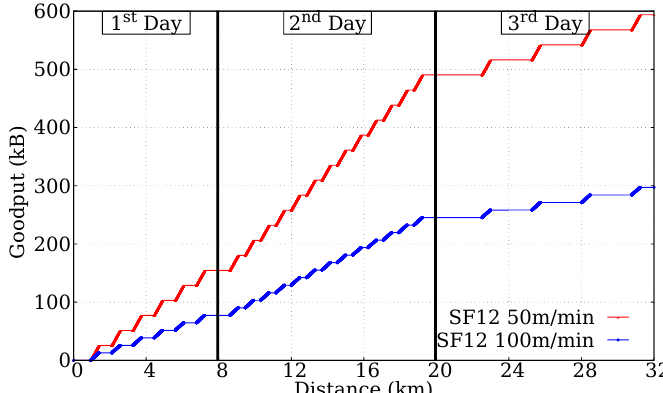
Figure 20. Accumulated load offered to the network as a function of distance and speed of the visitor (mobile node) in the